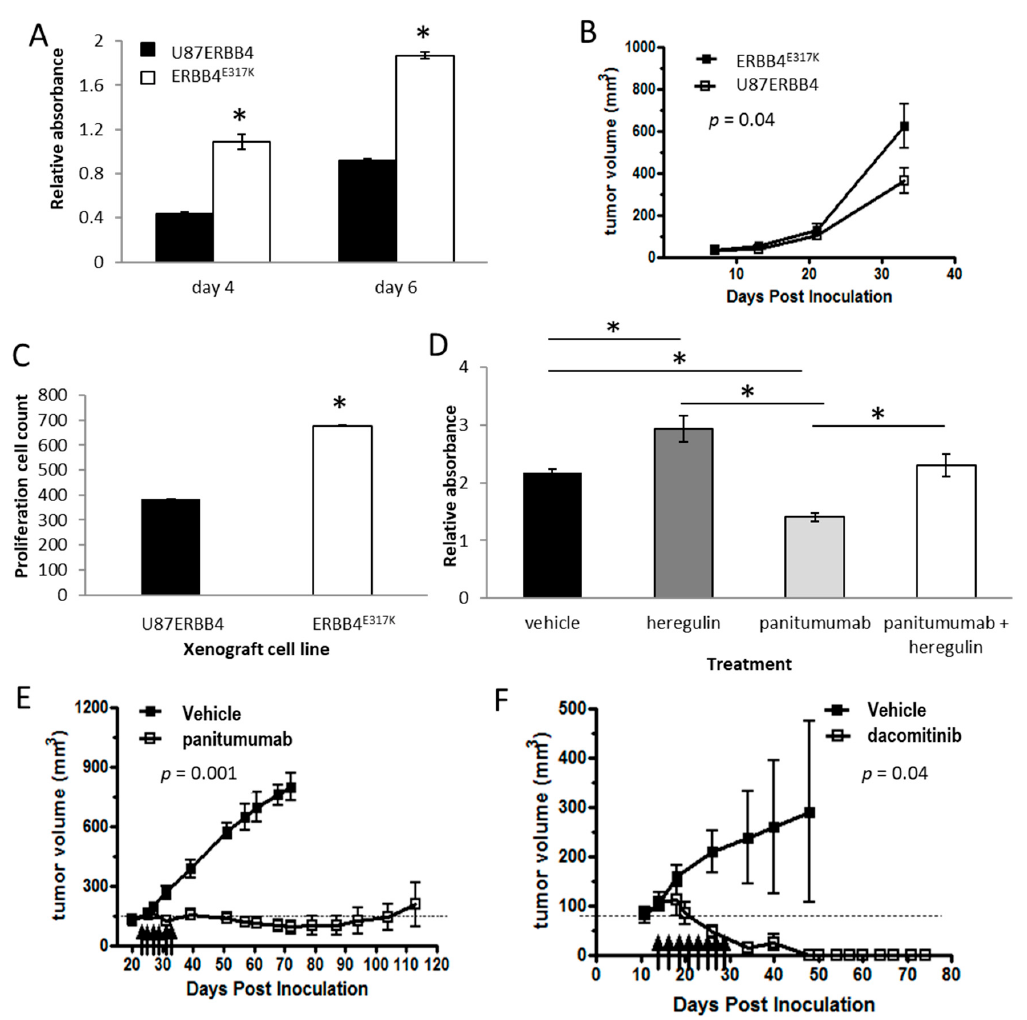
Figure 5. Activated ERBB4 and cell growth potential. The proliferation of U87MG cells infected